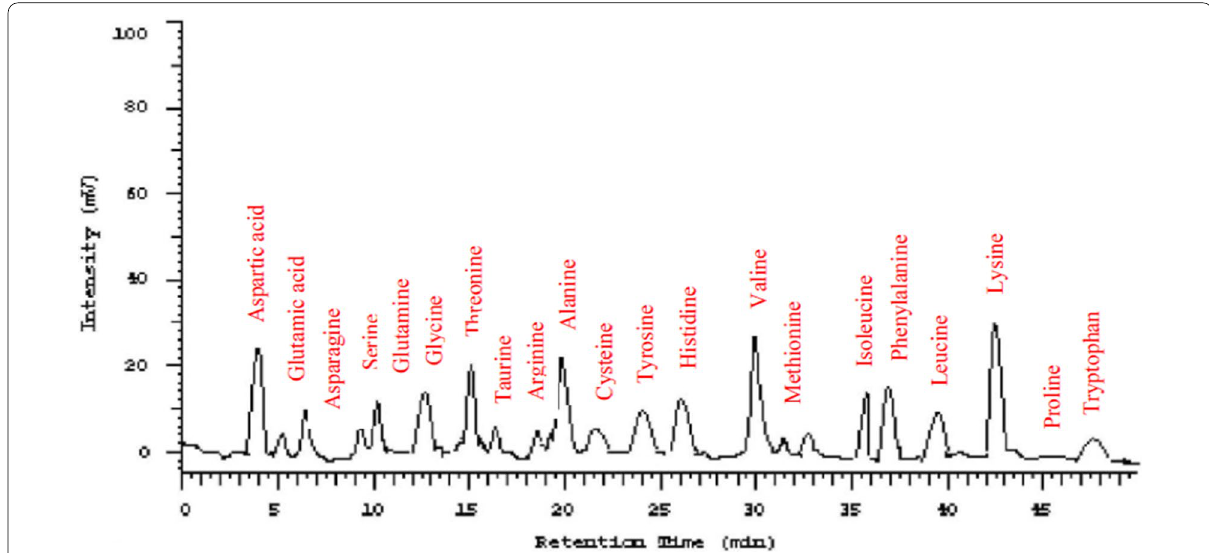
Fig. 3 Peak graphs denoting the amino acids quantified using the HPLC technique